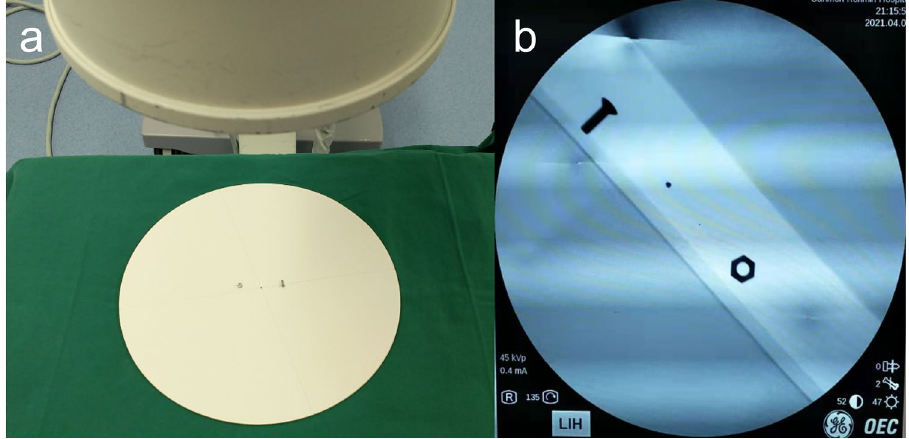
Figure 9. ( a ) C-arm camera without the locator shot the circular plate ( X = 30 cm, Y = 0°). ( b ) Positional relationship between the center nail of the display circular plate and the center point of the display.